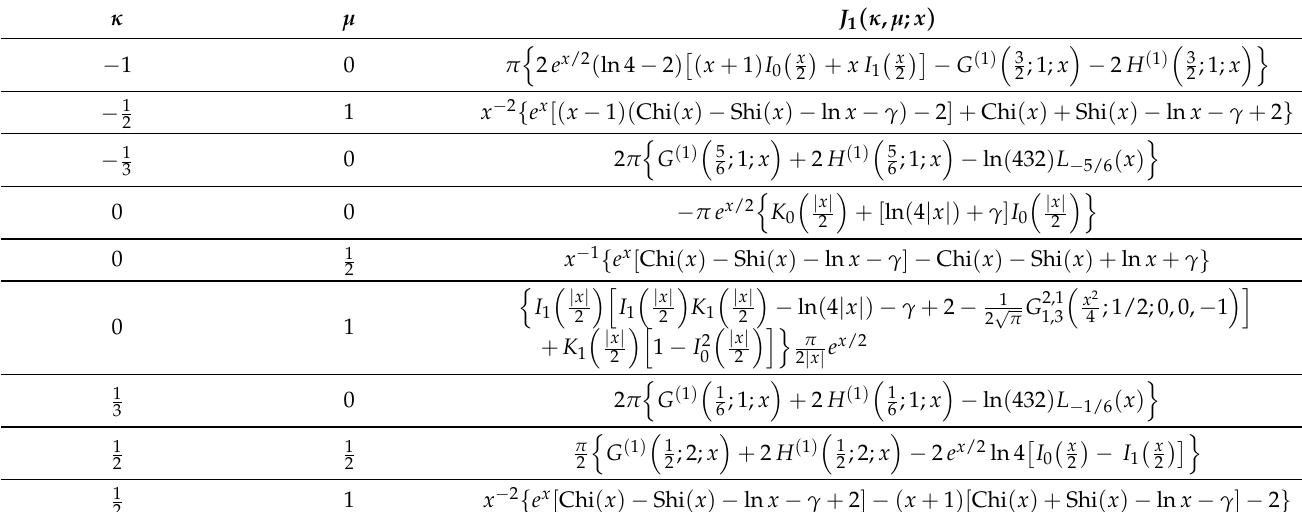
Table 8. Integral J 1 ( κ , µ ; x ) for particular values of κ and µ